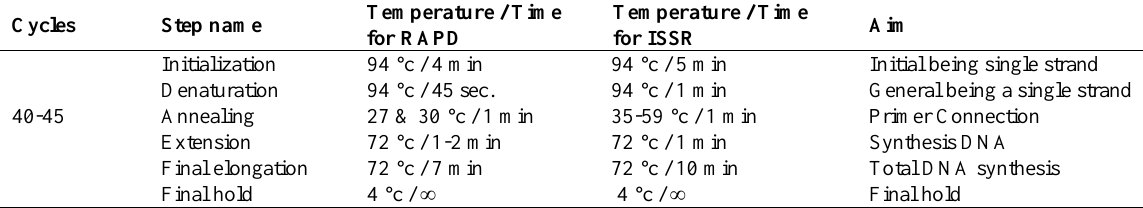
Temperature / Time for RAPD